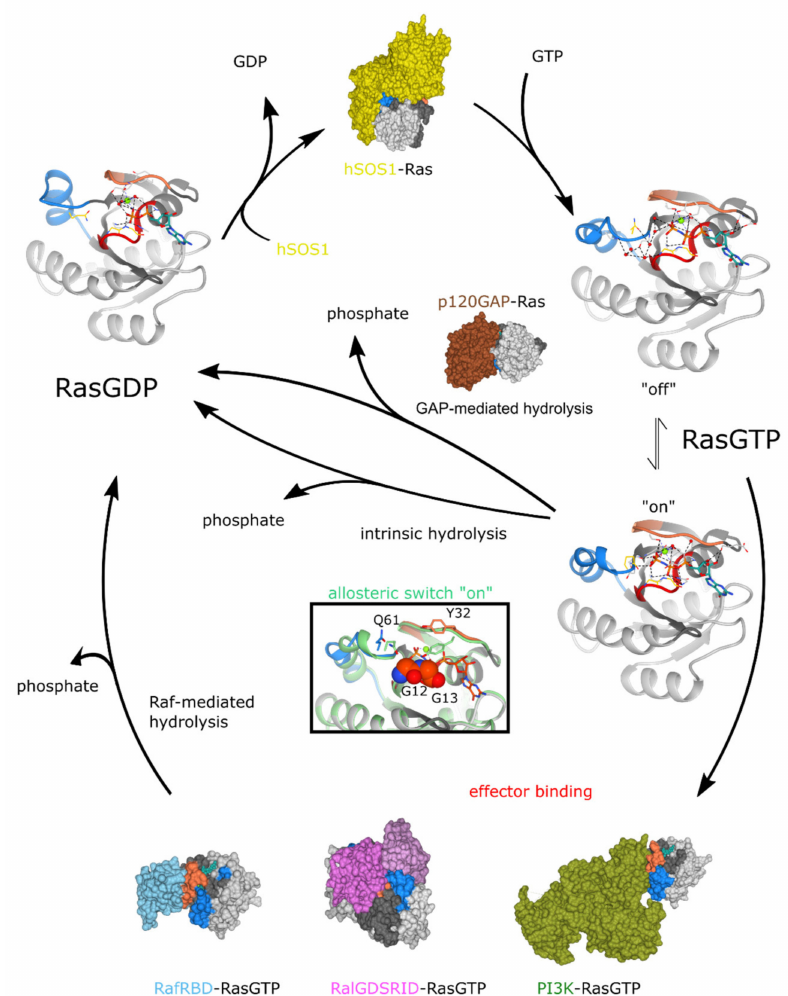
Figure 3. Ras proteins cycle. Ras proteins (gray) nucleotide exchange is catalyzed by Ras Guanine nucleotide Exchange Factors (GEFs) such as hSOS1 (in yellow). Ras GTP can assume di ff erent conformations due to an allosteric switch that is in the dynamic equilibrium between an “o ff ” state (PDB ID: 5p21) and an “on” state (PDB ID: 3K8Y), both spontaneously and in dependence of Ras GTPase Activating Proteins (GAPs) (such as p120GAP in brown and PDB ID: 1WQ1) or Ras e ff ectors binding. A detail of the “on” conformation (in green) is shown in the insert, superimposed on the “o ff ” conformation: the rearrangement in the position of residues Q61 in switch II and Y32 in switch I is evident. The presence of the two glycines in positions 12 and 13 (represented as spheres) are mandatory to allow this rearrangement, which is fundamental for the catalytical mechanism of GTP hydrolysis. Three of the main e ff ectors of Ras are shown in complex with Ras GTP: Raf Ras-binding domain (RBD) is in light blue (PDB ID: 4G0N), RalGDS Ras-interacting domain (RID) are in pink and purple (PDB ID: 1LFD), and PI3K catalytic subunit is in green (PDB ID: 1HE8). Note that RalGDS binds Ras GTP as a heterotetramer. All of the e ff ectors bind Ras only in the active form due to their higher a ffi nity for the Ras GTP conformation of the e ff ector lobe (dark grey). Ras switch I is in orange, and switch II is in blue. The nucleotide is in green sticks, while Q61 and Y32 are shown as yellow sticks in Ras proteins